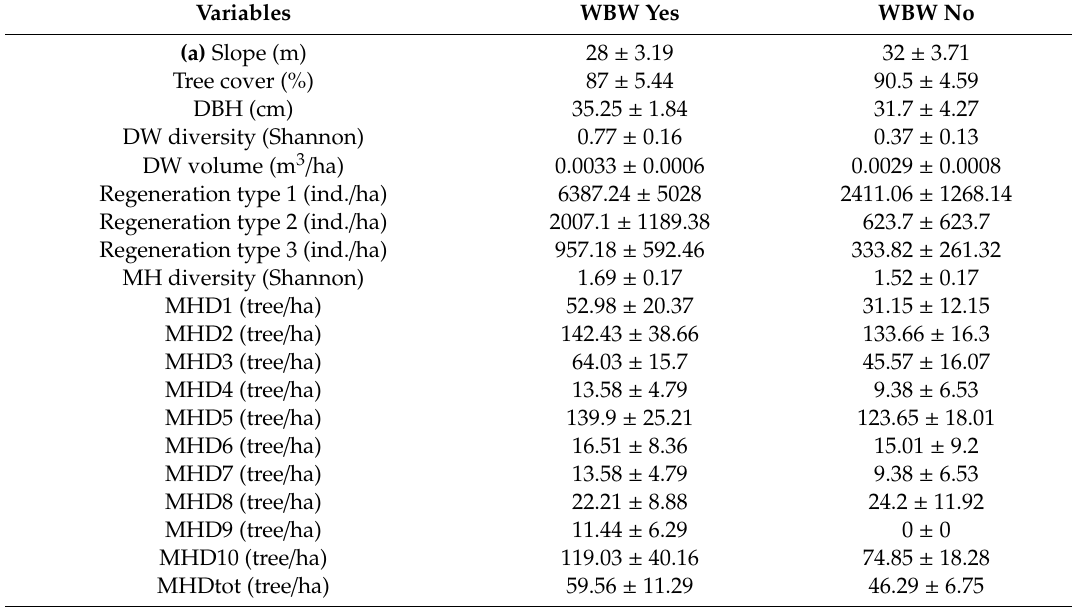
Table A2. Mean ± standard error of the variables from the circular plots ( a ) and transects ( b ) in the WBW territories (WBW yes) and the non-WBW territories (WBW no). DW = deadwood; MH = microhabitat; MHD 1-10 = density of the microhabitat specified by the number; C, SC, N, D = density of DW in a state with bark (C), without bark (SC), to be cut with a knife (N), to be broken with the fingers (D); E10, E20, E30 = density of DW with a diameter of 10, 20, or 30